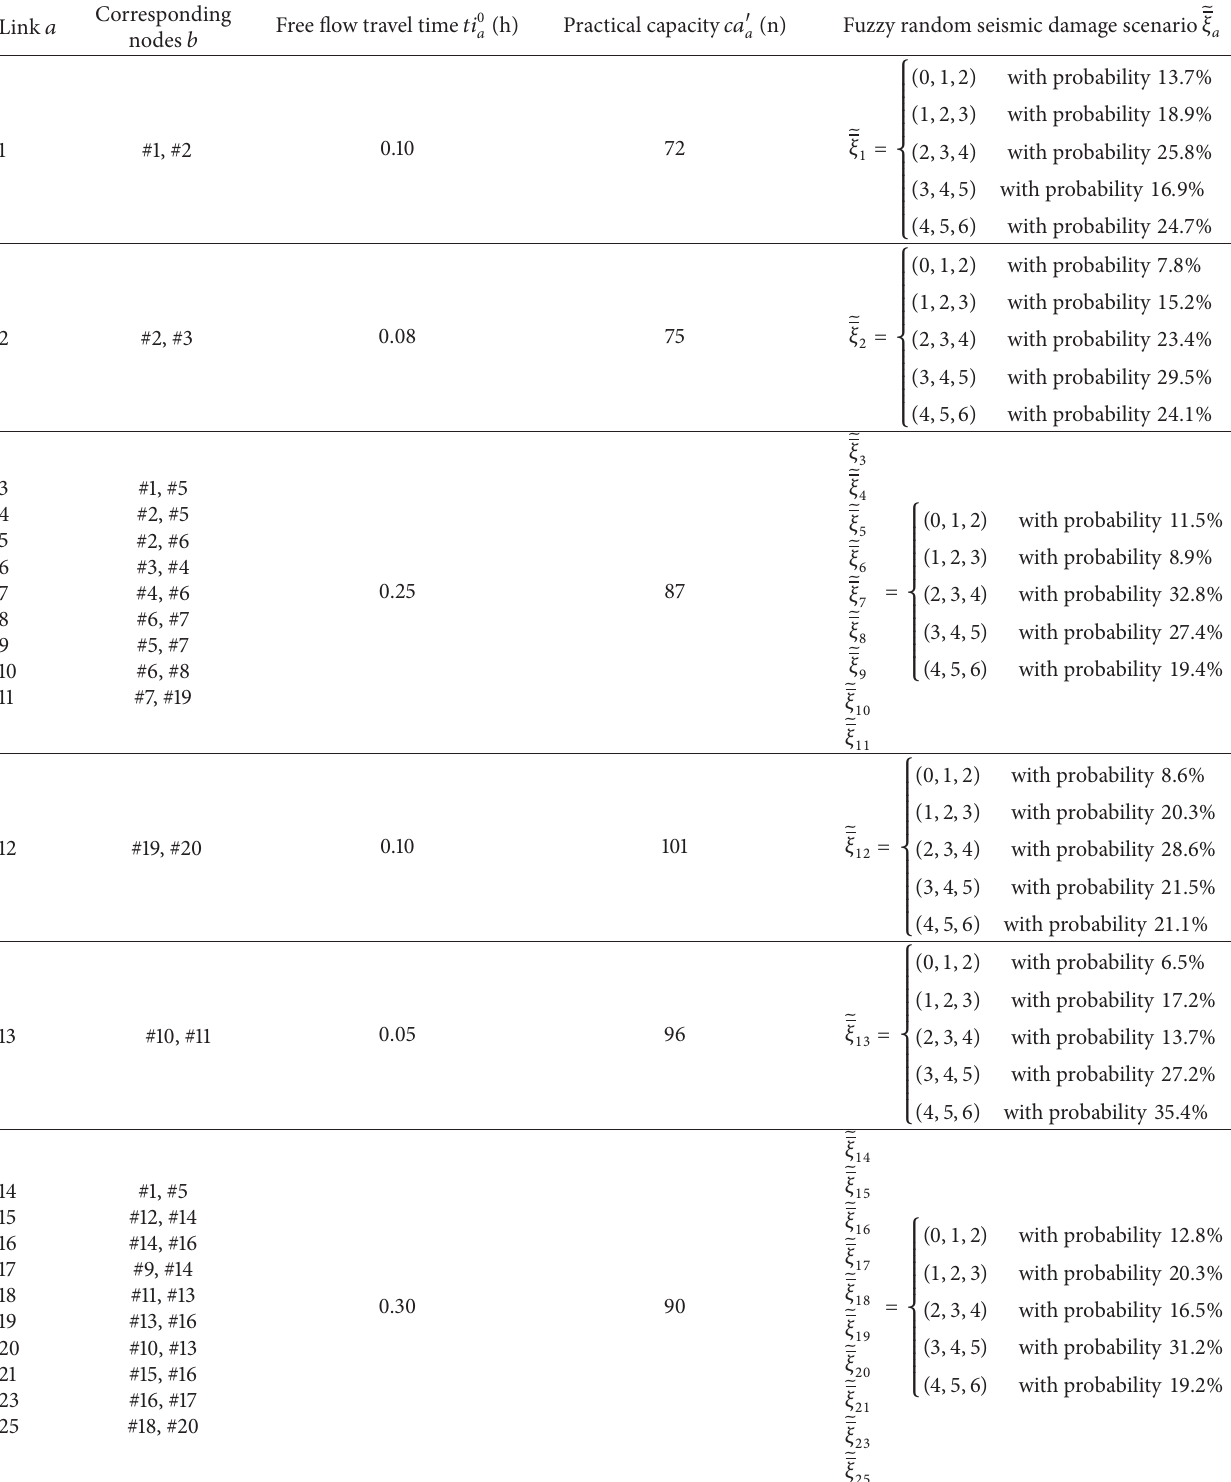
̃ 𝜉 𝑎 of each link.